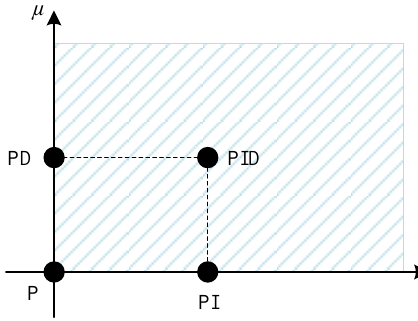
Figure 5. Graphical representation of the different PID controllers.